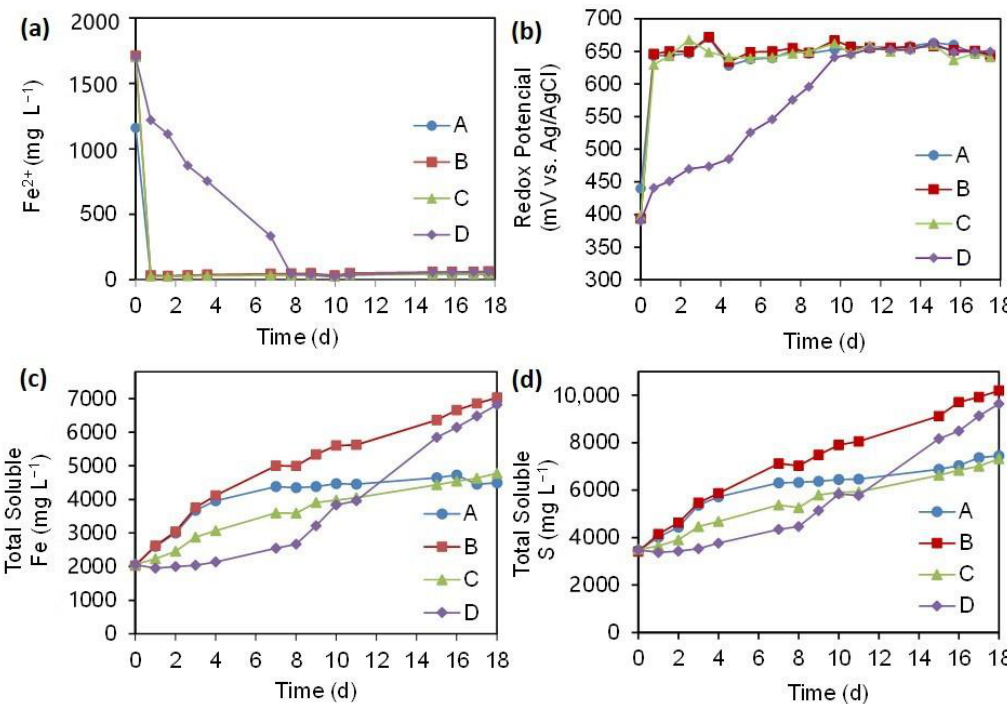
Figure 8. ( a ) Ferrous iron, ( b ) redox potential (vs. Ag/AgCl), ( c ) total soluble iron, and ( d ) sulfur during the pyrite oxidation experiment with reactors A, B, C, and D. organic compounds may inhibit the activity of some bioleaching microorganism and also slow down abiotic pyrite oxidation with Fe 3+ [17 – 19]. DOC concentrations in the leach liquors at the end of the pyrite oxidation experiment were 76, 40, 27, and 30 mg L − 1 for reactors A, B, C, and D, respectively. The DOC concen- tration was highest in reactor A, followed by reactors B, D, and C. A photo of the super- natants of the reactor slurries collected at the end of the pyrite oxidation experiments is shown in Figure 9. The supernatants collected from A (with the highest initial cell density) after mineral solids separation with short centrifugation at 3350× g for 5 min appeared to be most turbid, probably due to higher cell densities. High concentrations of dissolved